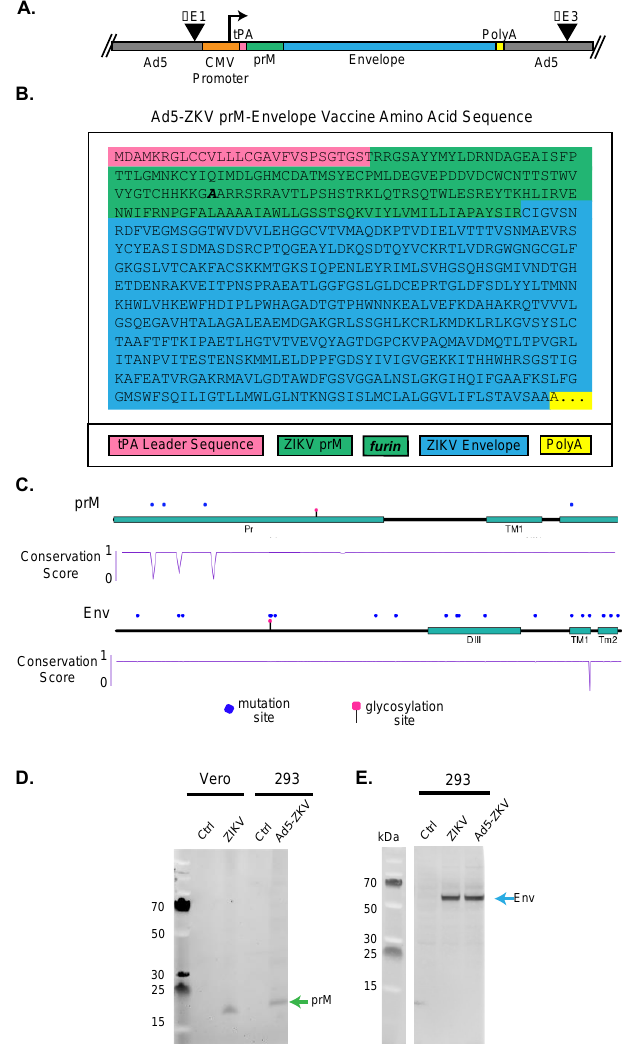
Figure 1. Development of human adenovirus type 5 Zika virus vaccine (Ad5-ZKV). ( A ) Schematic representation of the ZIKV structural protein expression cassette. hAd5 lacks the E1 and E3 coding regions, which are replaced with a cytomegalovirus (CMV) promoter-driven ZIKV cassette that expresses a codon-optimized tissue plasminogen activator (tPA) leader sequence followed by pre-membrane (prM) and full-length envelope (E) protein (hAd5-ZKV). ( B ) Expression cassette: The amino acid sequence of the tPA leader sequence, prM, and E based upon ZIKV strain PRVABC59 (ANK57897.1). The point mutation to increase furin cleavage is in bold. ( C ) Protein plot of prM and E. Using 249 ZIKV human isolate sequences, amino acid variations that occurred at a frequency above 0.08% (equal or greater than 2 variations at any particular site) were marked using a blue dot above the cartoon representation of the prM and E proteins. The cartoon representation consists of tracks highlighting key protein domains such as the pr portion of the prM and the DIII of the envelope. Below the cartoon representation is a track of the conservation score of the protein at each site that describes the level of identity between the ZIKV sequences based on amino acid variations. In this conservation plot, a score of 1 is representative of 100% amino acid identity, and a score of 0 is representative of 0% amino acid identity. ( D ) ZIKV prM protein expression from ZIKV and hAd5-ZKV: Vero cells were infected with ZIKV PRVABC-59, and 293F cells were infected with hAd5-ZKV, then cellular lysates were run on a SDS-PAGE non-reducing gel. prM was detected with rabbit anti-ZIKV prM (GTX-133305). ( E ) ZIKV E protein from ZIKV- and hAd5-ZKV-infected cells was detected with mouse anti-E 4G2.